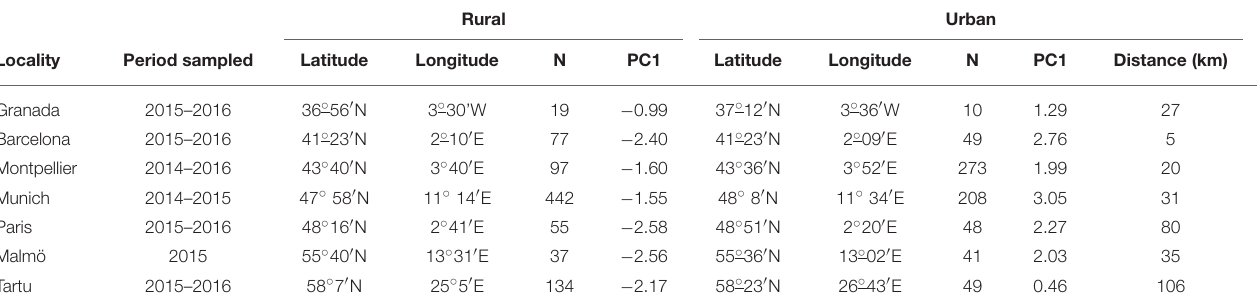
TABLE 1 | Sampling localities of urban and rural great tits ( Parus major ) across